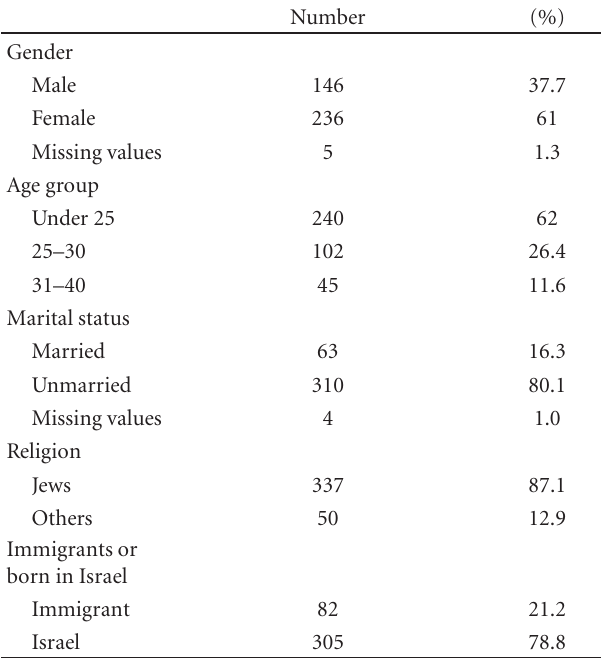
Table 1: Sample’s